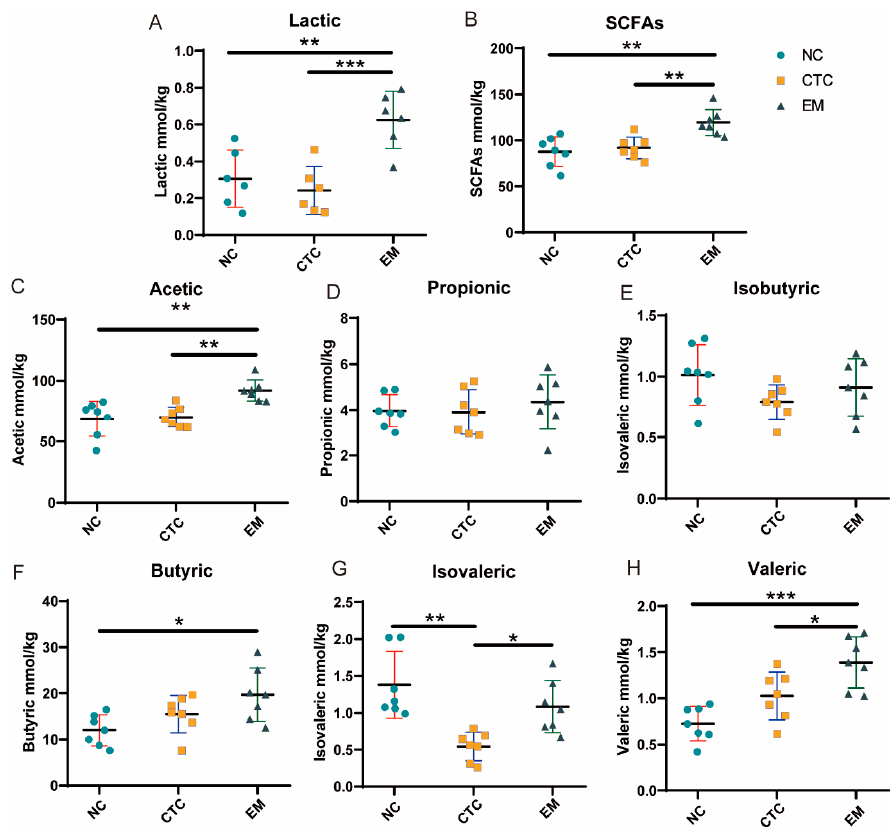
Figure 4. Effects of NC, CTC and EM on the concentrations of ( A ) lactic acid, ( B ) total SCFAs, ( C ) acetic acid, ( D ) propionic acid, ( E ) isobutyric acid, ( F ) butyric acid, ( G ) valeric acid, and ( H ) isovaleric acid in broiler cecum. * p < 0.05, ** p < 0.01, *** p < 0.001. N = 6 per treatment group.